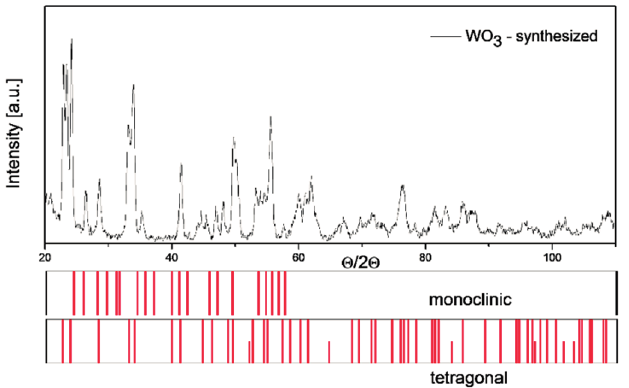
Figure 4. X-ray diffractograms of the powder WO 3 obtained in the thermal decomposition process of the tungstic-silicic